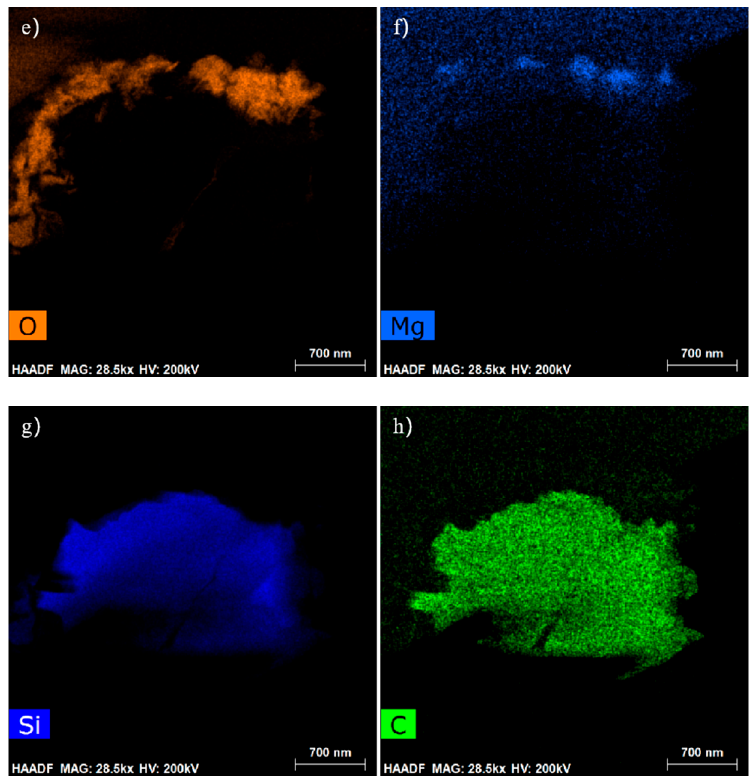
Figure 11. The transmission map scanning after compression: ( a ) The bright-field image; ( b ) The distribution of all elements, The element distribution of ( c ) Al; ( d ) Cu; ( e ) O; ( f ) Mg; ( g ) Si; ( h ) C. Materials 2021 , 14 , x FOR PEER REVIEW